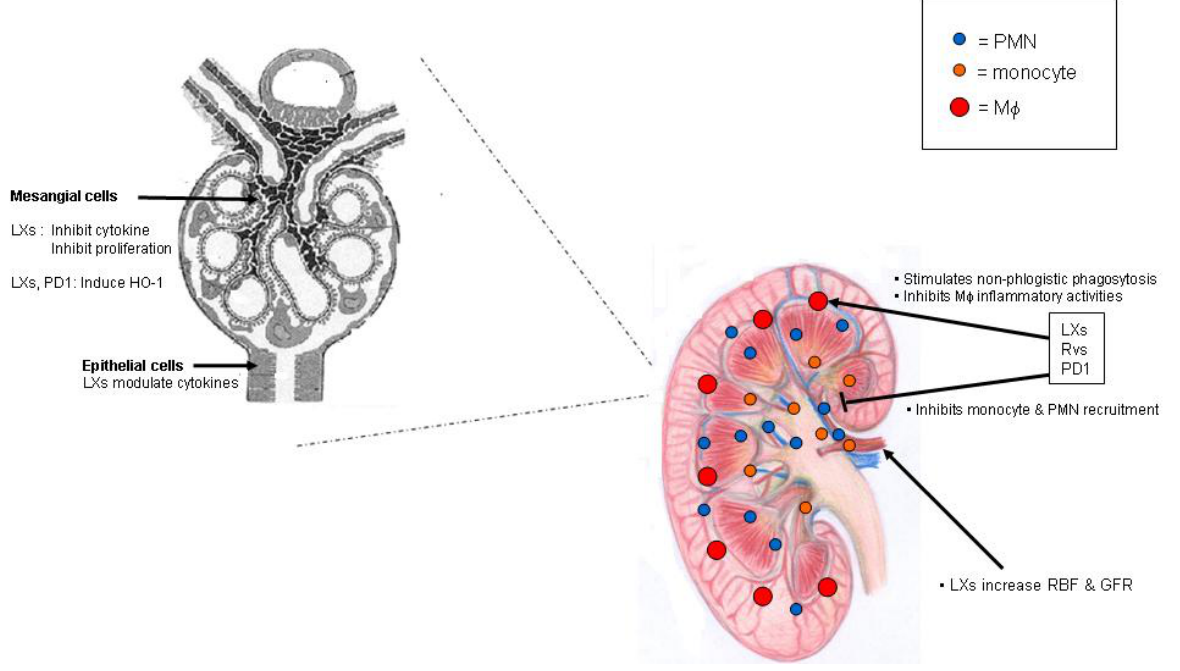
FIGURE 3. Bioactions of lipoxins, resolvins, and protectins during resolution of renal inflammation. As renal inflammation proceeds, leukocyte infiltration is pronounced and causes many deleterious effects. Lipoxins (LXs), resolvins (Rvs), and protectins (PD) inhibit the recruitment of polymorphonuclear cells (PMNs) and monocytes[57]. They also stimulate macrophages (M  ) to nonphlogistically phagocytose apoptotic cells and inhibit inflammatory activities of M  , e.g., by shifting their cytokine production from inflammatory to resolving[64]. LXs have also been shown to increase renal blood flow (RBF) and glomerular filtration rate (GFR)[107]. Furthermore, LXs modulate cytokine production from both epithelial and mesangial cells, as well as inhibit mesangial proliferation[64]. Finally LXs and PD1 induce the heme- oxygenase-1 (HO-1) pathway, which has been shown to be renoprotective[66]. (Modified from Poussu[133].)